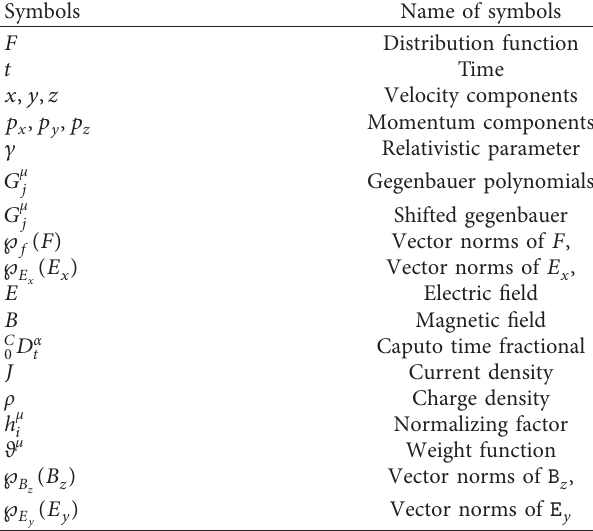
Table 1: Important symbols used in the